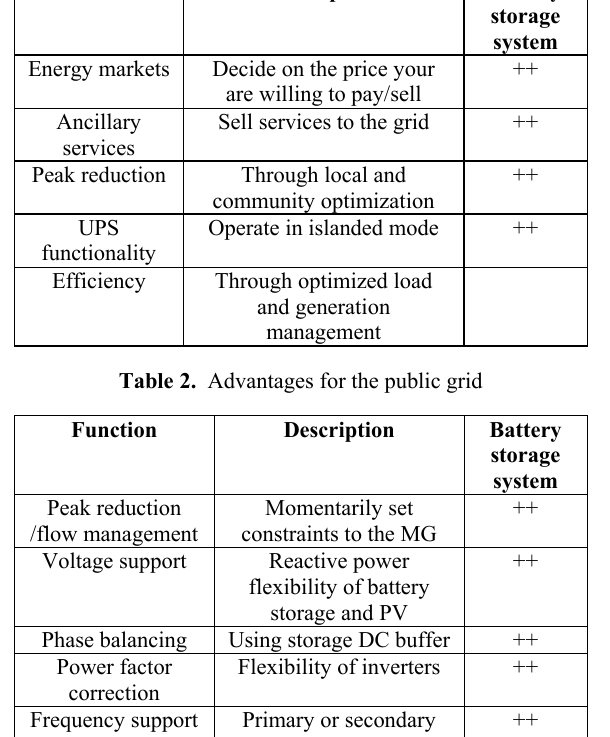
Table 1. The creation mechanisms of a grid-tied MG Function